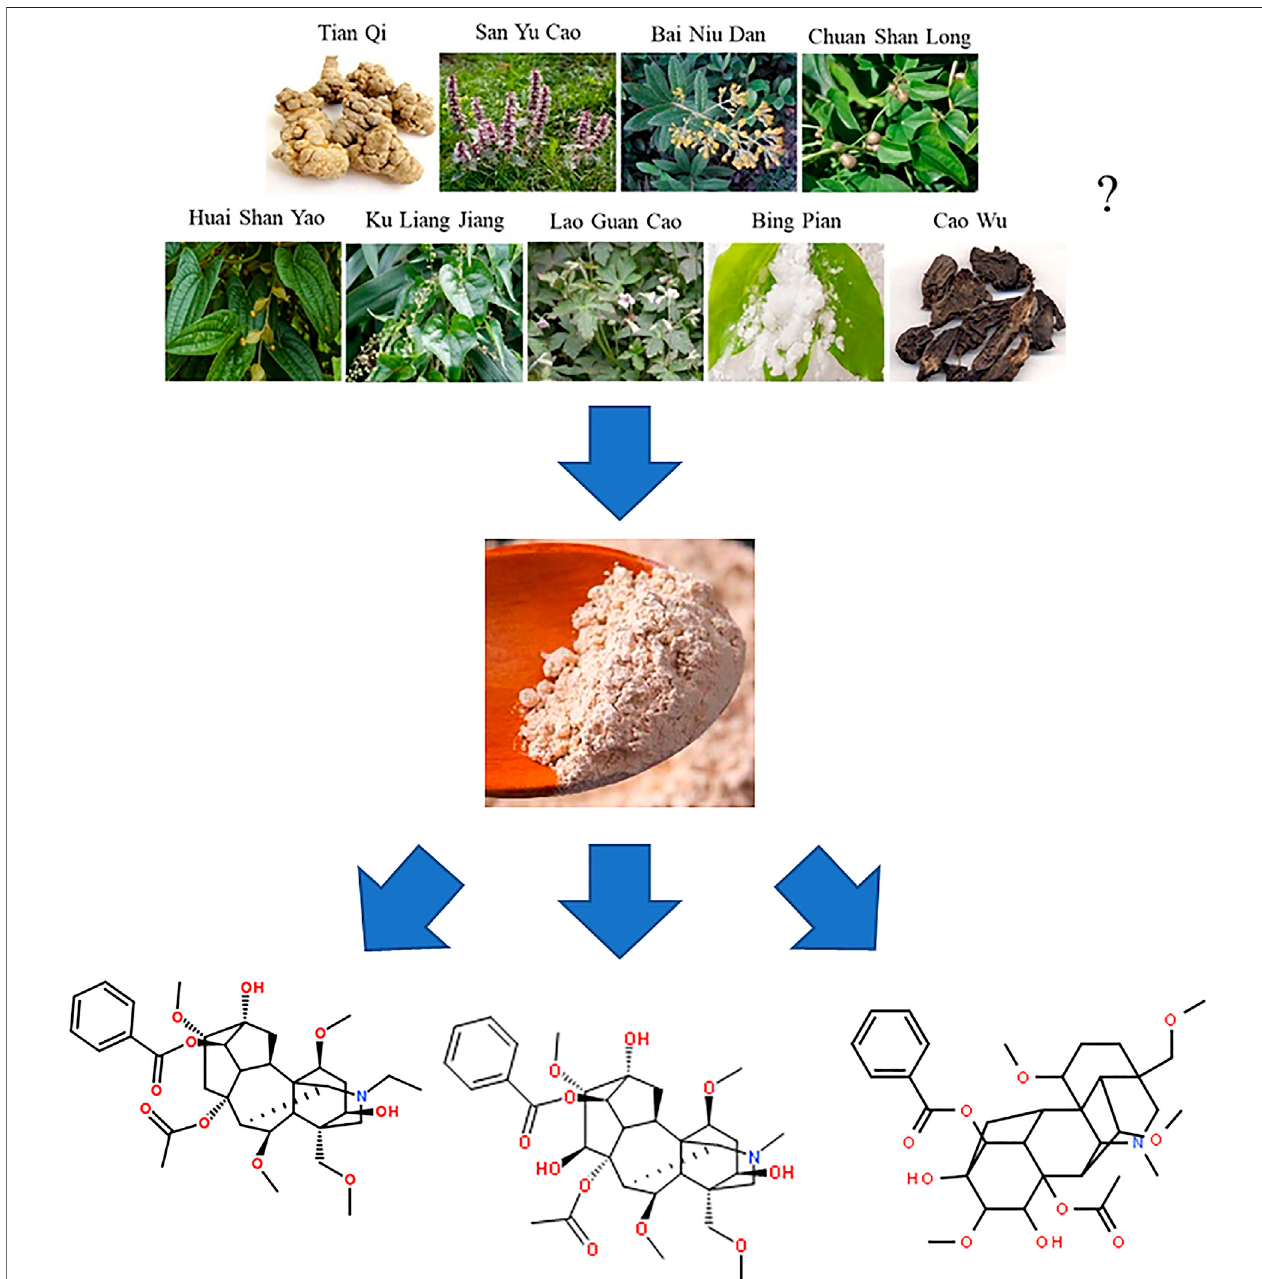
FIGURE 2 | The possible prescription of Yunnan